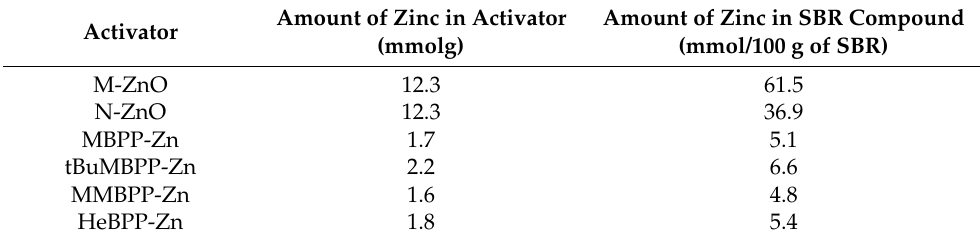
Table 1. General formulations of the styrene-butadiene-rubber (SBR) compounds, parts per hundred of rubber (phr); MBT, 2-mercaptobenzothizole; CBS, N-cyclohexyl-2-benzothiazolesulfenamide; M-ZnO, microsized zinc oxide; N-ZnO, zinc oxide nanopowder; CB, carbon black. Reference SBR Compound SBR Compound with Ingredient Sample with N-ZnO Zinc Complexes 1 SBR 100 100 100 Sulfur 2 2 2 CBS 1 1 1 MBT 1 1 1 CB 30 30 30 M-ZnO 5 - - N-ZnO - 3 - Zinc complex - 30 3